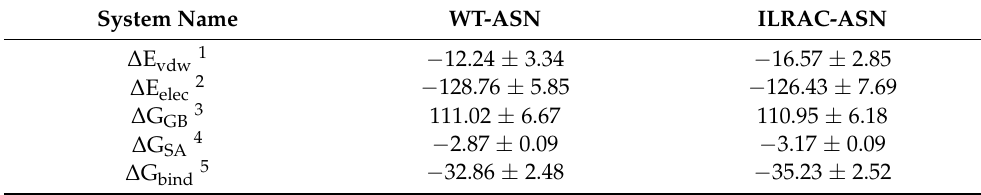
Table 4. Binding free energies and energy components calculated by MM/GBSA (kcal/mol).